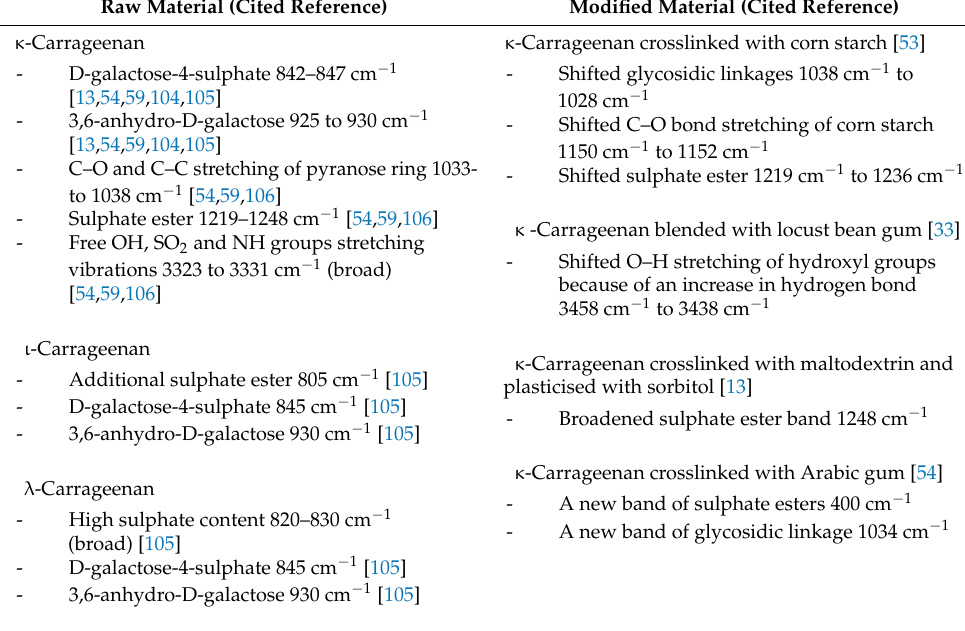
Table 8. FTIR spectral band of seaweed-based